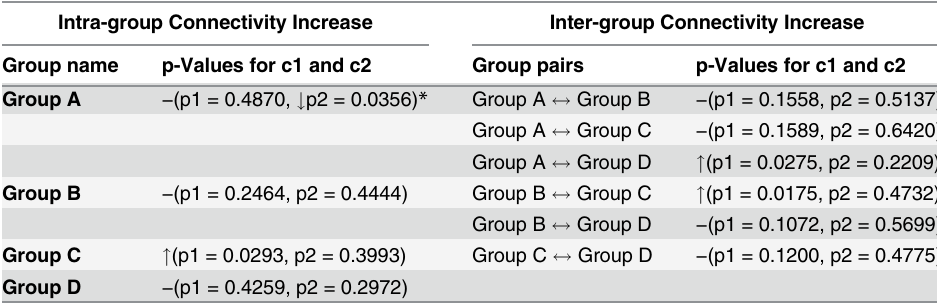
Table 4. The difference in the intra- and inter-group connectivity among sub-networks in the upper alpha band between the NE-IL and the NE-IT conditions. Intra-group Connectivity